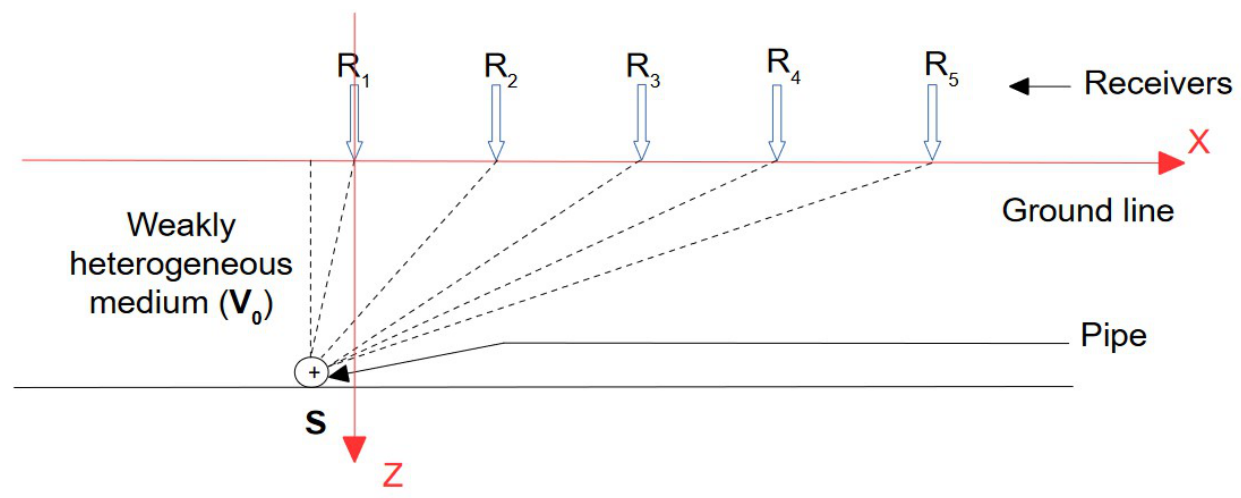
Figure 1. Scheme of Model M1: case of a single propagation